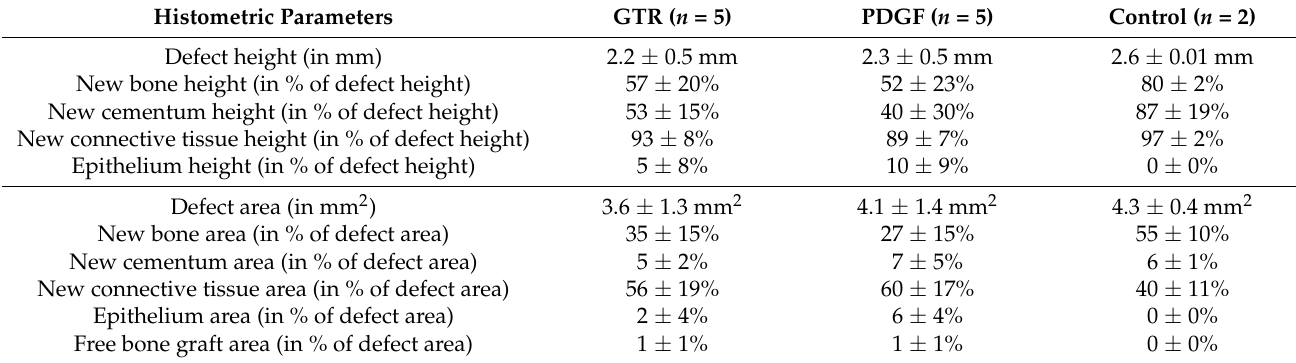
Table 2. Histometric results in horizontal class III furcation